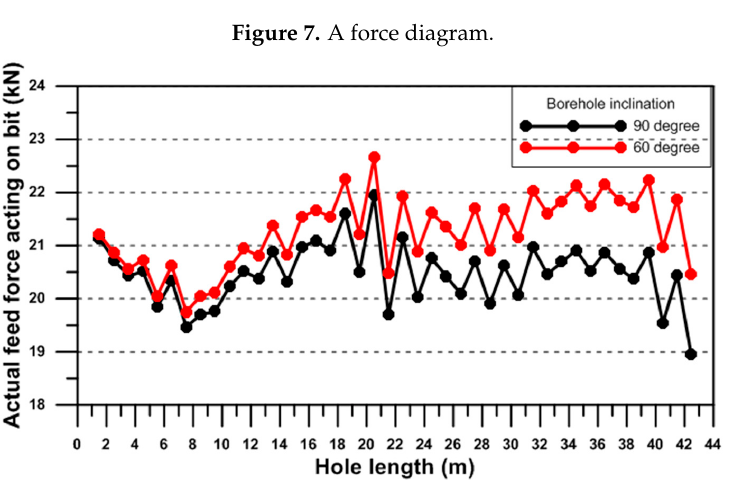
Figure 8. Actual feed force versus hole length for different inclinations of the borehole.